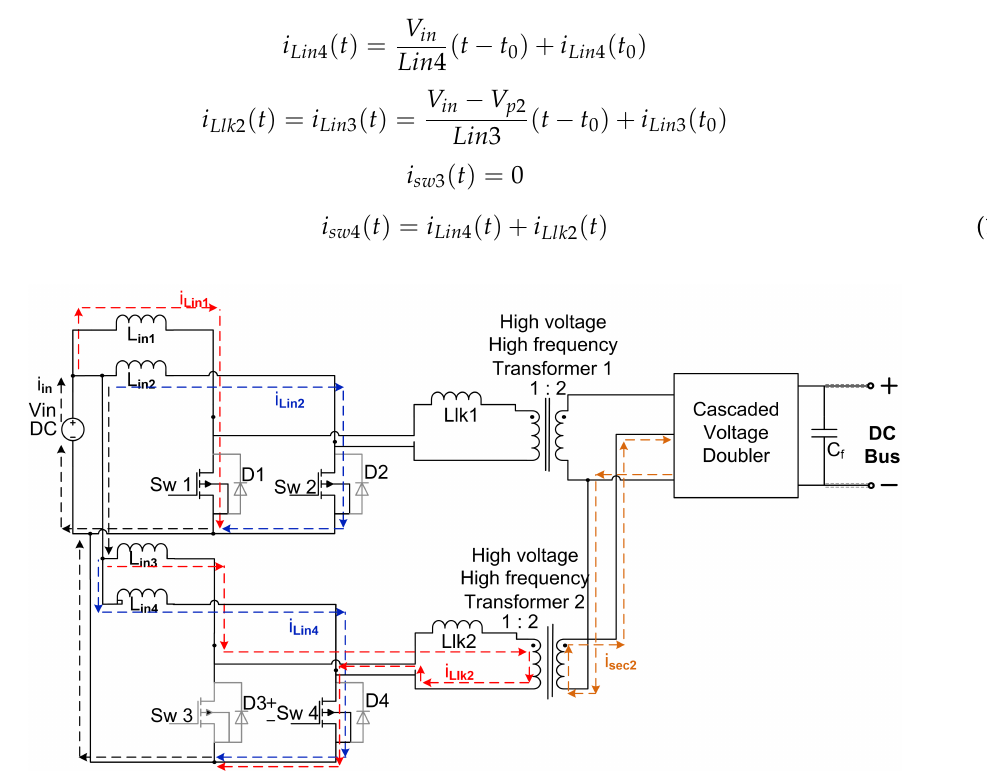
Figure 3. Mode 1 operation.